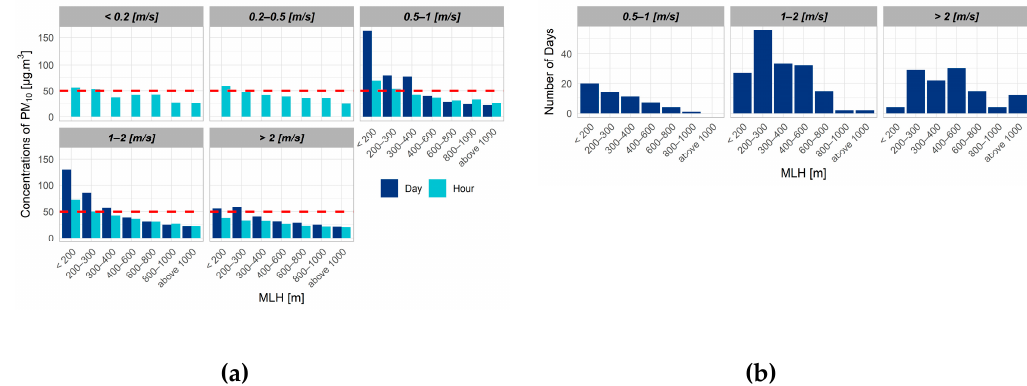
Figure 12. The T ř inec-Kosmos site, 2016–2019: ( a ) Average PM 10 concentrations depending on the mixing layer height and wind speed; ( b ) The count of exceedances of daily concentrations of 50 µg.m − 3 depending on the mixing layer height and wind speed.